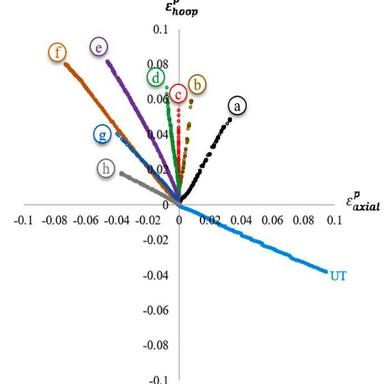
Strain paths for the nine deformation modes (one uniaxial and eight biaxial a-h).